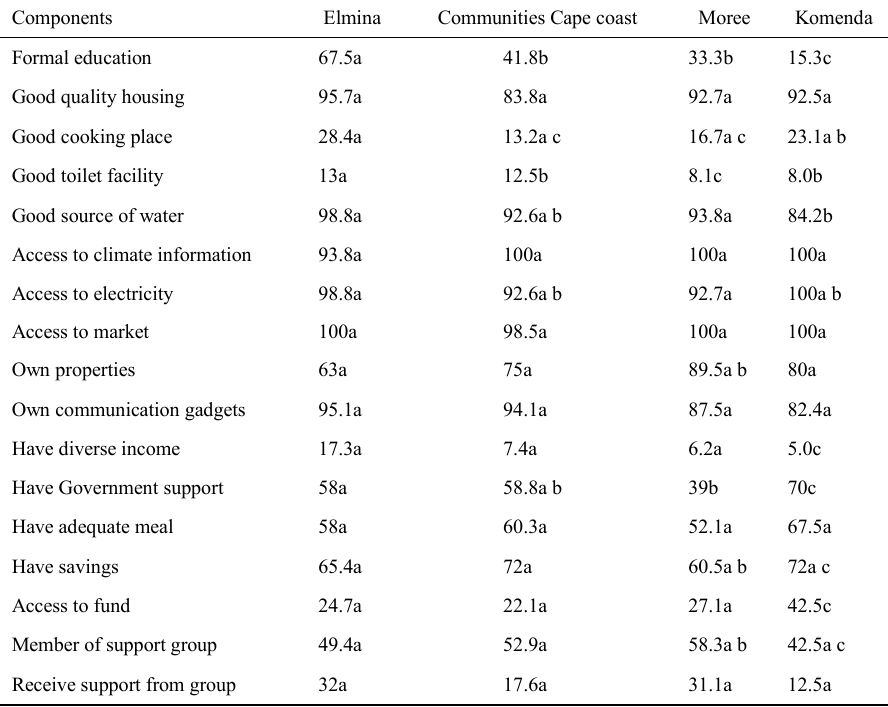
Table 2: Values of indicators of vulnerability for the four communities